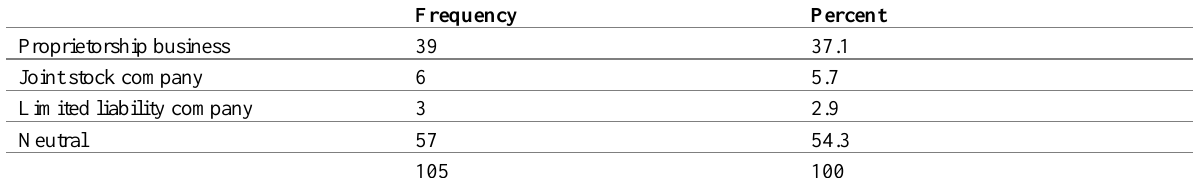
Table 5: With the aid of my remittances, family members started one of the